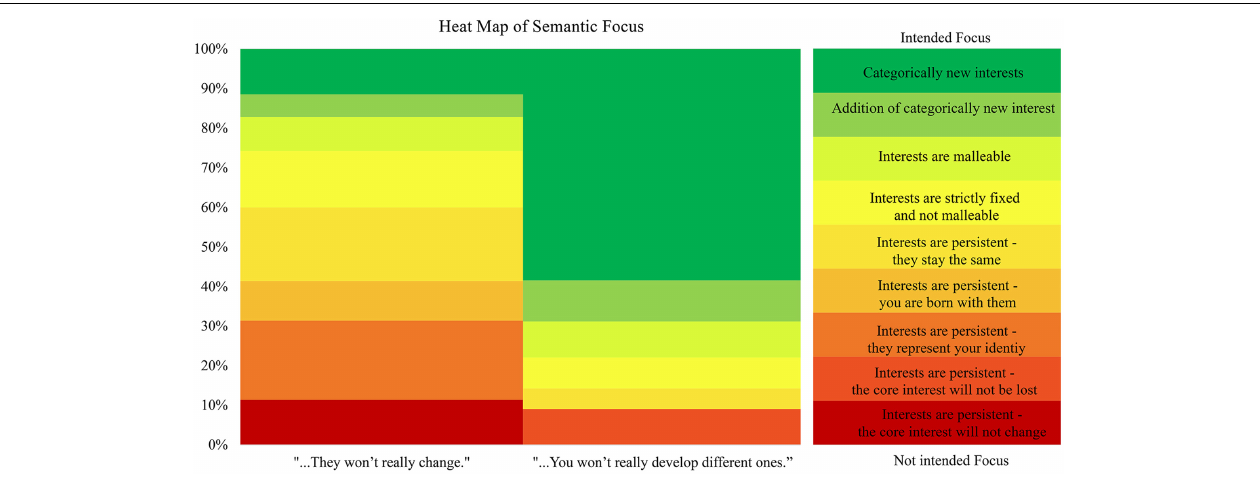
FIGURE 2 | The percentage of participants who indicated the three categories of code in response to an open-ended request for reflection to the item.